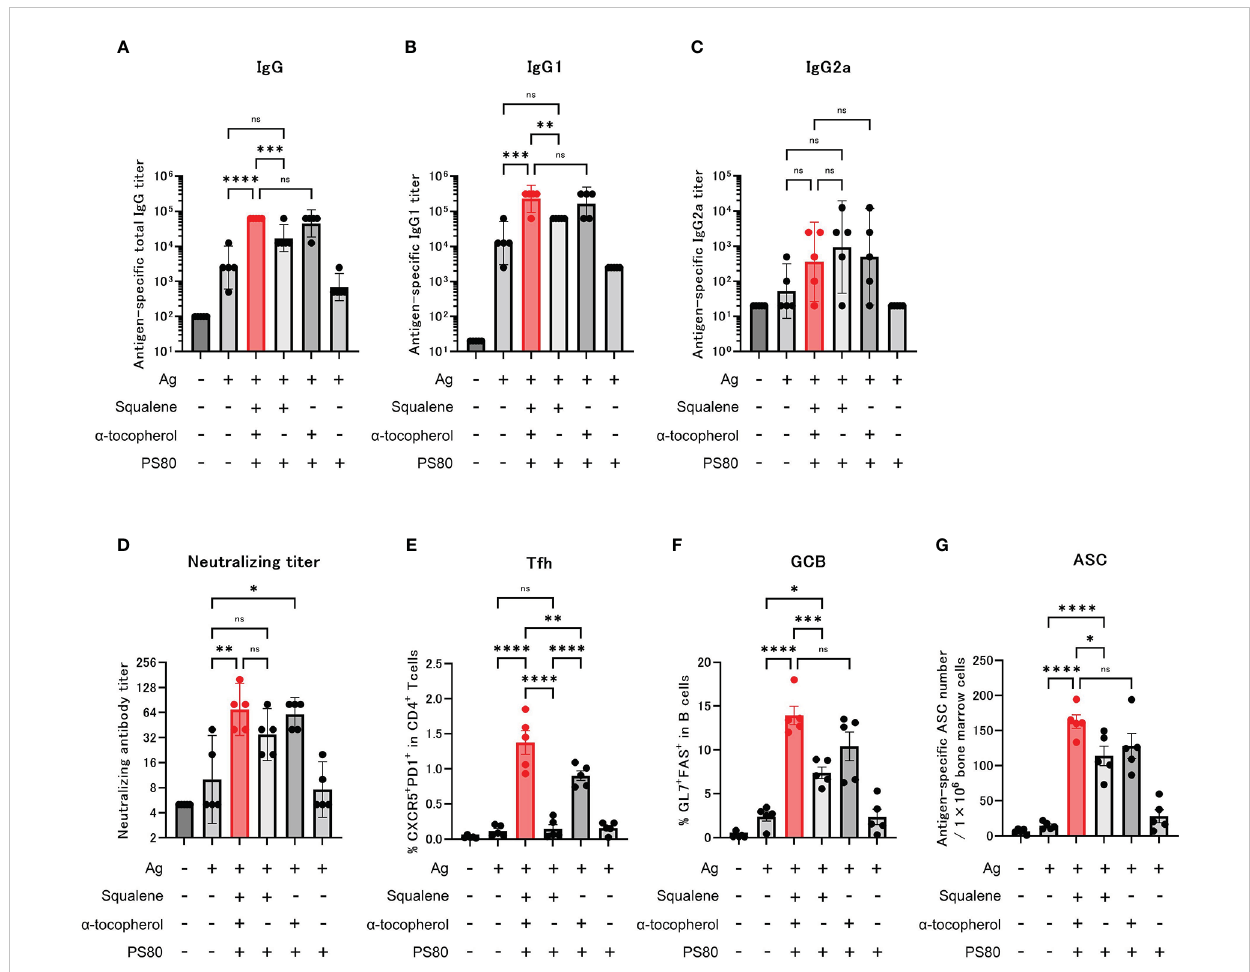
FIGURE 4 a -tocopherol, a component of A-910823, is important for the ef fi cient induction of IgG, Tfh and GCB cells. Balb/c mice were injected IM with the respective vaccine or vehicle on days 0 and 14 (n=5/group). (A – C) Antigen-speci fi c total IgG, IgG1, and IgG2a titers on day 28. Each bar represents the GMT; error bars indicate the 95% con fi dence interval. Each circle represents the titer in individual mice. (D) Serum titers of neutralizing antibodies against SARS-CoV-2 on day 28. Each bar represents the GMT; error bars indicate the 95% con fi dence interval. Each circle represents the neutralizing antibody titer in individual mice. (E) Percentages of Tfh (PD1+CXCR5+) cells in TCRb+CD4+ cells and (F) percentages of GCB (FAS+GL7 +) cells in CD19+ cells in the draining lymph nodes on day 28. Each bar represents the mean; error bars indicate the standard error of the mean. Each circle represents the percentages of Tfh and GCB cells in individual mice. (G) The number of ASCs in bone marrow on day 77 was determined by ELISpot. Each bar represents the mean; error bars indicate the standard error of the mean. Each circle represents the antigen-speci fi c spot- forming cells in individual mice. Statistical signi fi cance was determined using Tukey ’ s multiple comparison test (ns, P ≥ 0.05, *P<0.05, **P<0.01, ***P<0.001, and